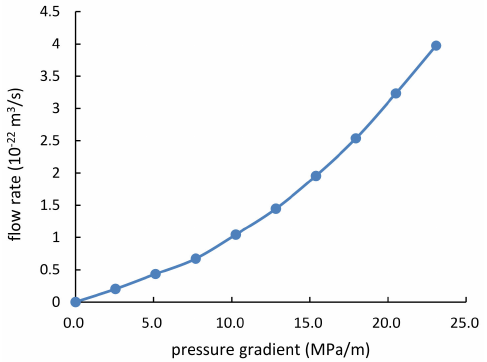
Figure 13. Flow rate vs. displacement pressure gradient for the real pore structure.